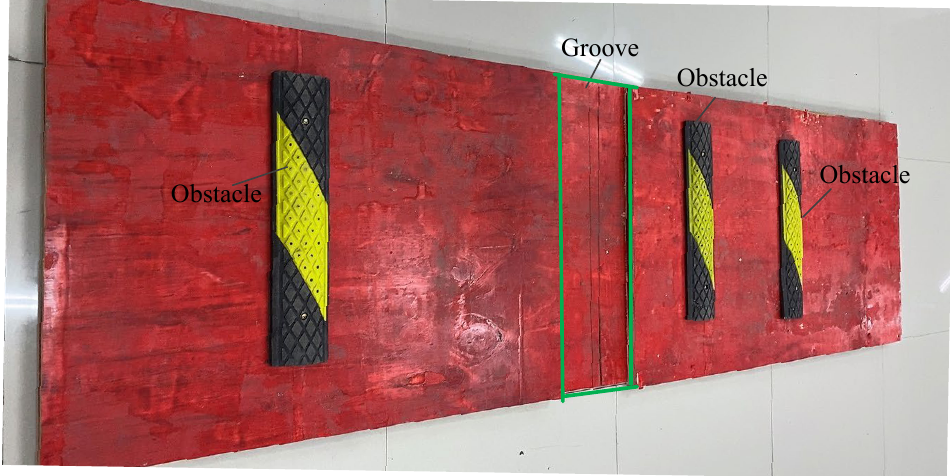
Figure 22. Pothole Complex Pavement.